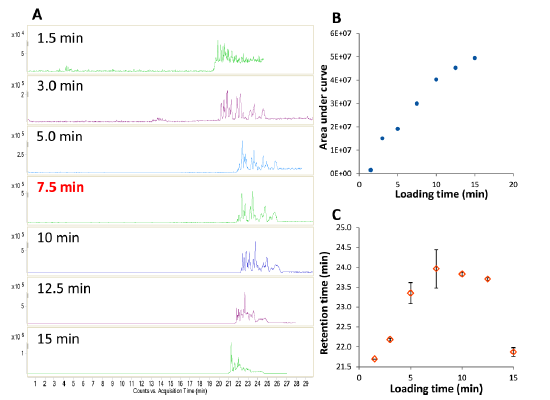
Figure 7 Sample loading capacity optimization. (A) BPC from CITP/CZE-ESI-MS with different sample loading time. (B) AUC of BPC presented in panel A with different sample loading